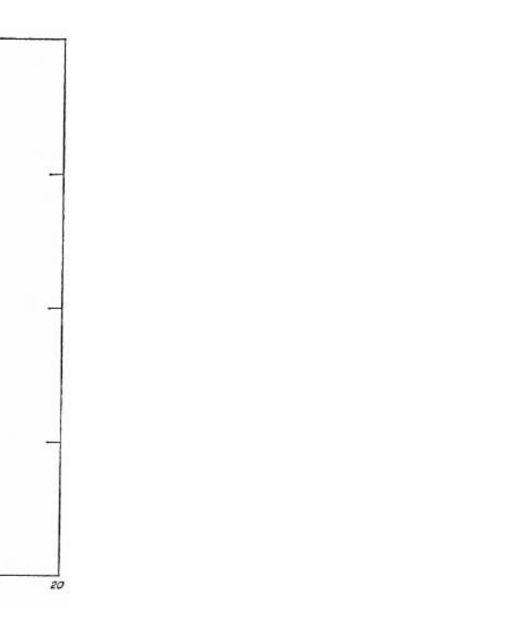
Figure 18. Dimensional changes in thickness in the third cycle which went from 65% RH to 100% RH [17].